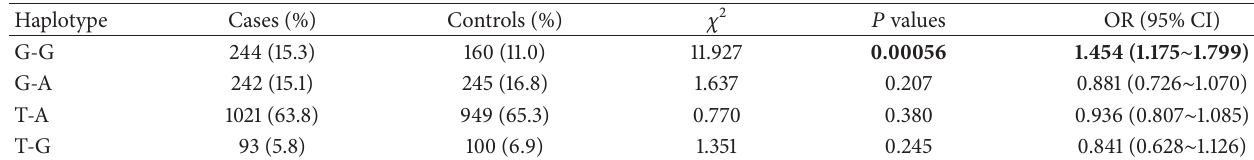
Table 4: Haplotype analysis between rs1057108 and rs2295415 in SLE association.